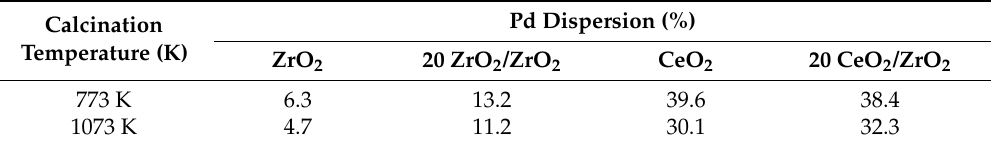
Table 2. Pd dispersions as a function of support calcination temperature.